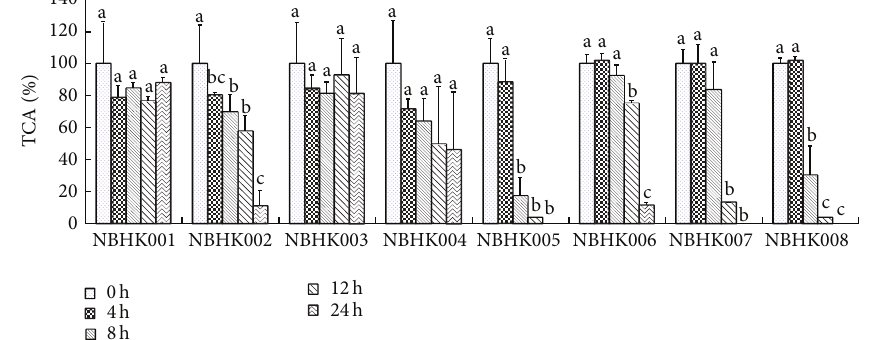
Table 1: Screening of the bile salt hydrolase (BSH) activity of probiotics using the plate assay method. Strain